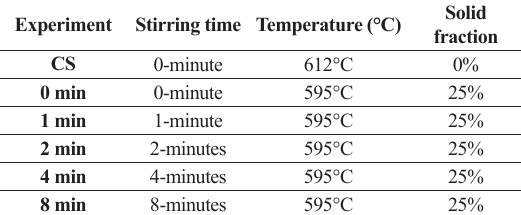
Figure 2. Thermal cycle applied in the processing. T Ts-Solidus temperature. T